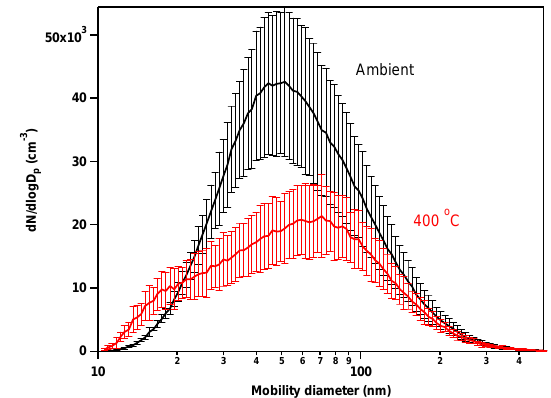
Figure 7. Average particle number size distribution (14 scans; 3min time span) for a major traffic period (HOA was around 70% of the OA), at ambient conditions (black) and 400 ◦ C, corrected for losses (red). Vertical lines correspond to confidence